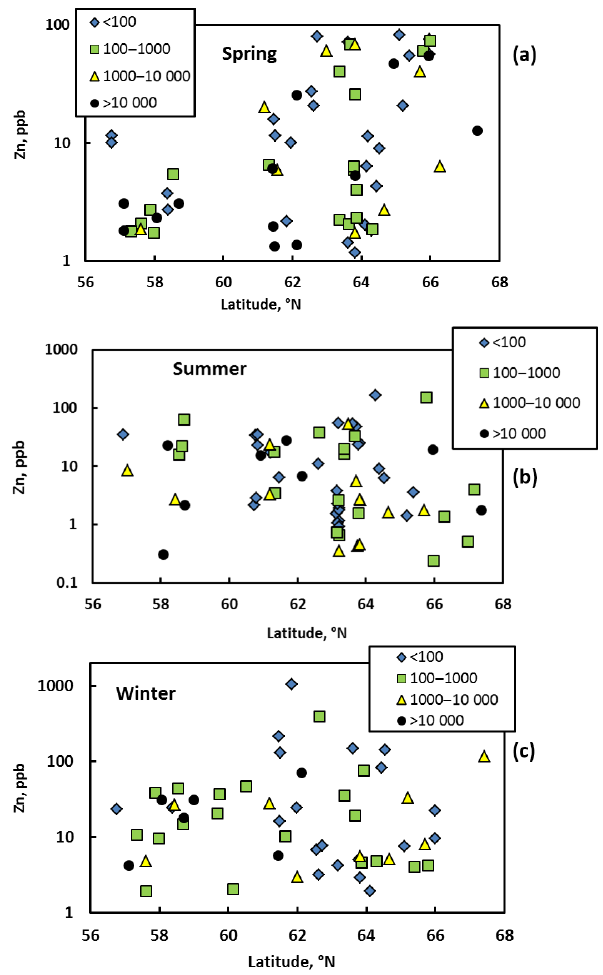
Figure 6. Variation in Zn concentration with latitude during spring (a) , summer (b) and winter (c) for watersheds of different size. The symbols are the same as in Fig. 2.